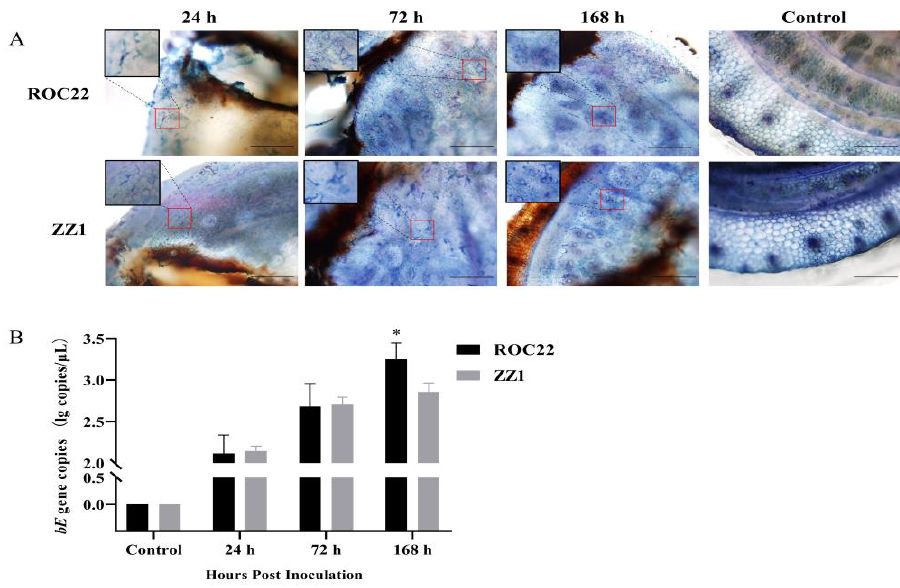
Figure 1. Visualization and quantification of S. scitamineum in sugarcane sprouts. ( A ) Sugarcane sprouts inoculated with S. scitamineum teliospores at different time points. The brown parts on the sprouts are the inoculation sites. The upper left corner is an enlarged view of the region indicated by the red box. Bars = 50 µ m. ( B ) Quantification of S. scitamineum bE gene copies in sugarcane sprouts, and this gene played a role in haploid sporidia mating. The DNA contents of all samples were 100 ng. After 168-h post-inoculation, the number of S. scitamineum copies differed significantly between ROC22 and ZZ1 (* p < 0.05). The sprouts without inoculation were considered as controls. Three biological replications were conducted, and each replication contained five